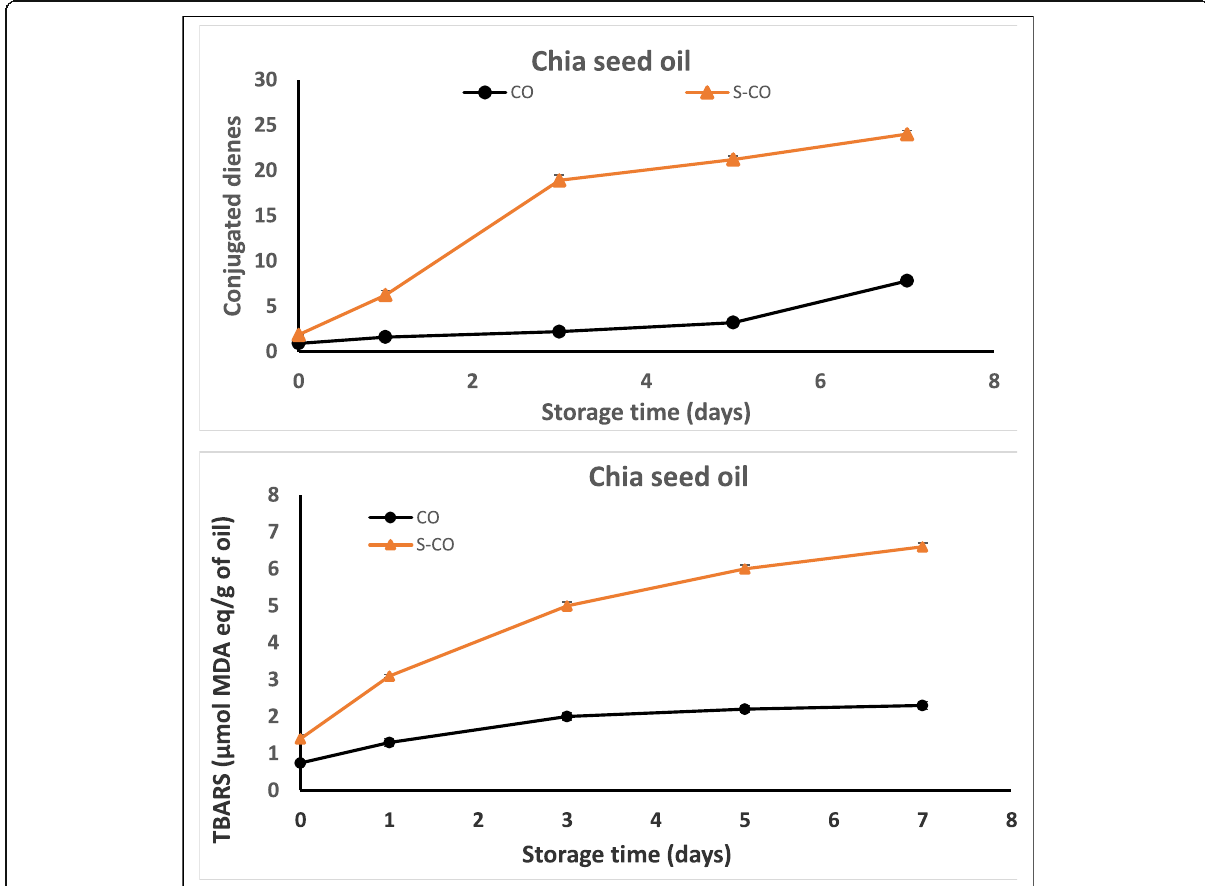
Fig. 2 Conjugated dienes and thiobarbituric acid reactive substances (MDA equivalents) of crude oil (CO) and stripped oil (S-CO) of chia oil seed during a 7-day storage at 60 °C under Schaal oven conditions ( p >